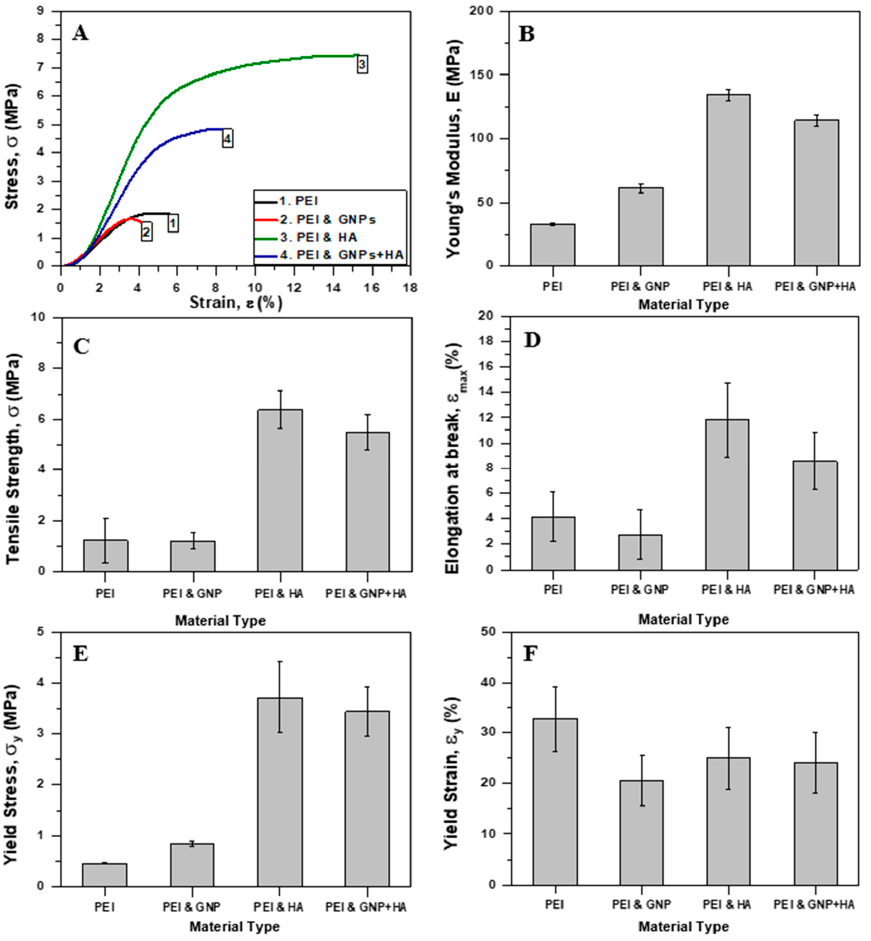
Figure 8. ( A ) Representative stress ( σ ) vs. strain ( ε ) % curves for pristine and nano-filler containing PEI sca ff olds (with GNPs, HAP and mixture of both). Bar chart diagrams providing the mechanical properties of PEI sca ff olds (pristine and nano-filler containing) that arose from uniaxial tensile tests; ( B ) Young’s modulus (E), ( C ) tensile strength ( σ max ), ( D ) elongation at break ( ε max ) %, ( E ) yield stress ( σ y ), and ( F ) yield strain ( ε y ) %. For all tensile properties standard deviations (SSD) are